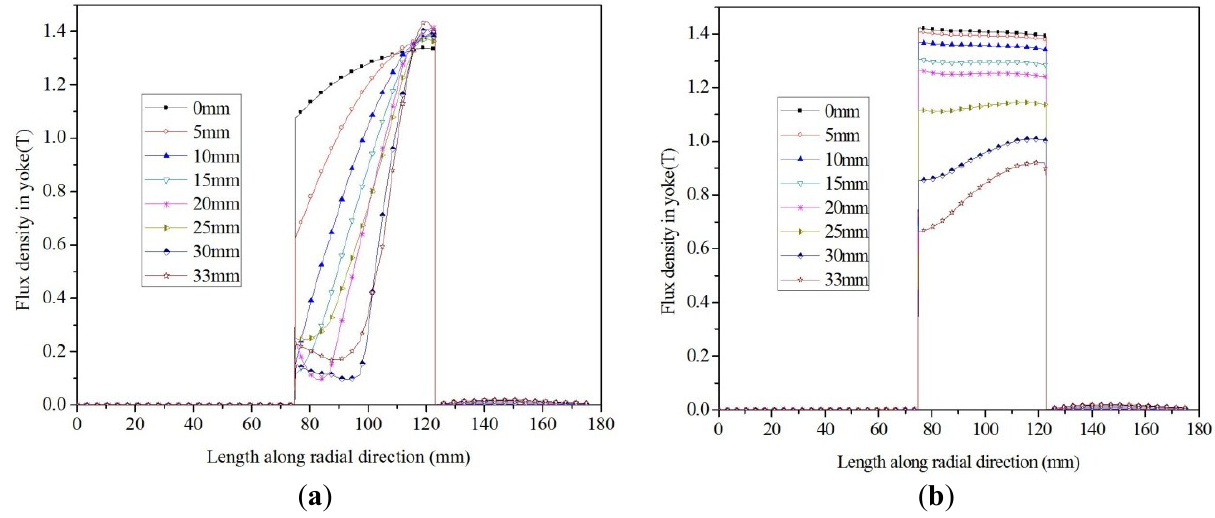
Figure 7. The magnetic flux density distributed in the teeth: ( a ) rolled lamination ( b ) SMC.